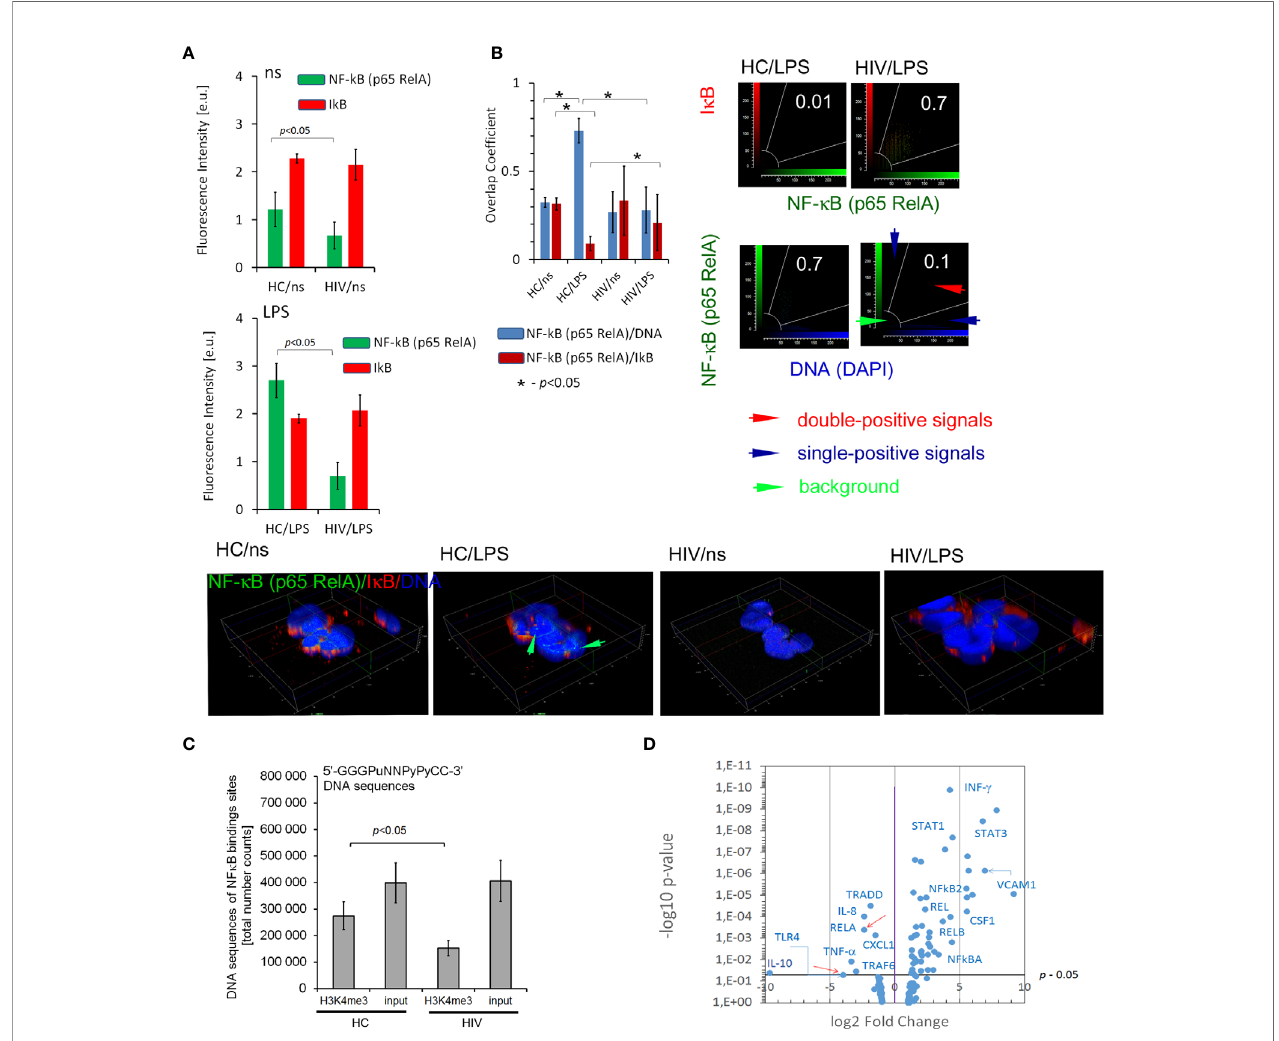
FIGURE 4 | HIV neutrophils are characterized by impaired NF- k B activation dependent on the p65-RelA subunit. (A) ICC fl orescent intensity analysis with double labeling for p65-RelA (green pseudocolor) and I k B (red) in non- and LPS-stimulated neutrophils. The bars represent average fl uorescence intensity ± SD calculated from four patients, using at least 100 single cells for each test. ( B right panel) Overlap coef fi cient of p65-RelA vs. I k B and p65-RelA vs. DNA analysis suggests p65- RelA colocalization with its inhibitor I k B which results in disturbance of p65-RelA relocation to the cell nucleus. ( B Low panel) ICC 3D projection of nucleus visualizes the lack of NF- k B (p65-RelA) colocalization with DNA after LPS-stimulation in HIV individuals. Green arrows show an overlap of signal from NF- k B (p65-RelA) and DNA in HCs. (C) Total amount of NF- k B binding sites within histone H3K4me3-marked in non-stimulated neutrophils. The bars represent mean ± SD for HCs (n=3) and HIV-infected individuals (n=3). (D) Disturbances in translocation of NF- k B to the nucleus are re fl ected in the pro fi le of mRNA expression of proin fl ammatory genes. The mRNA expression of all targets and genes associated with NF- k B are provided in the Supplementary Table S5